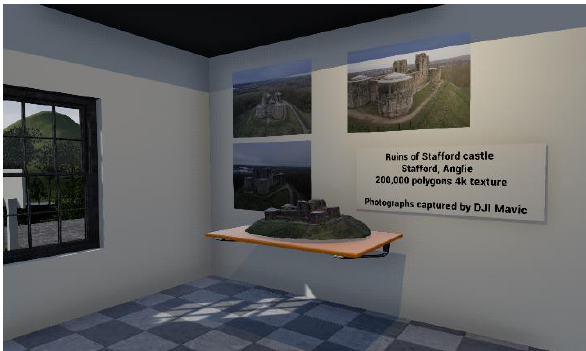
Figure 17. Texture detail – inside